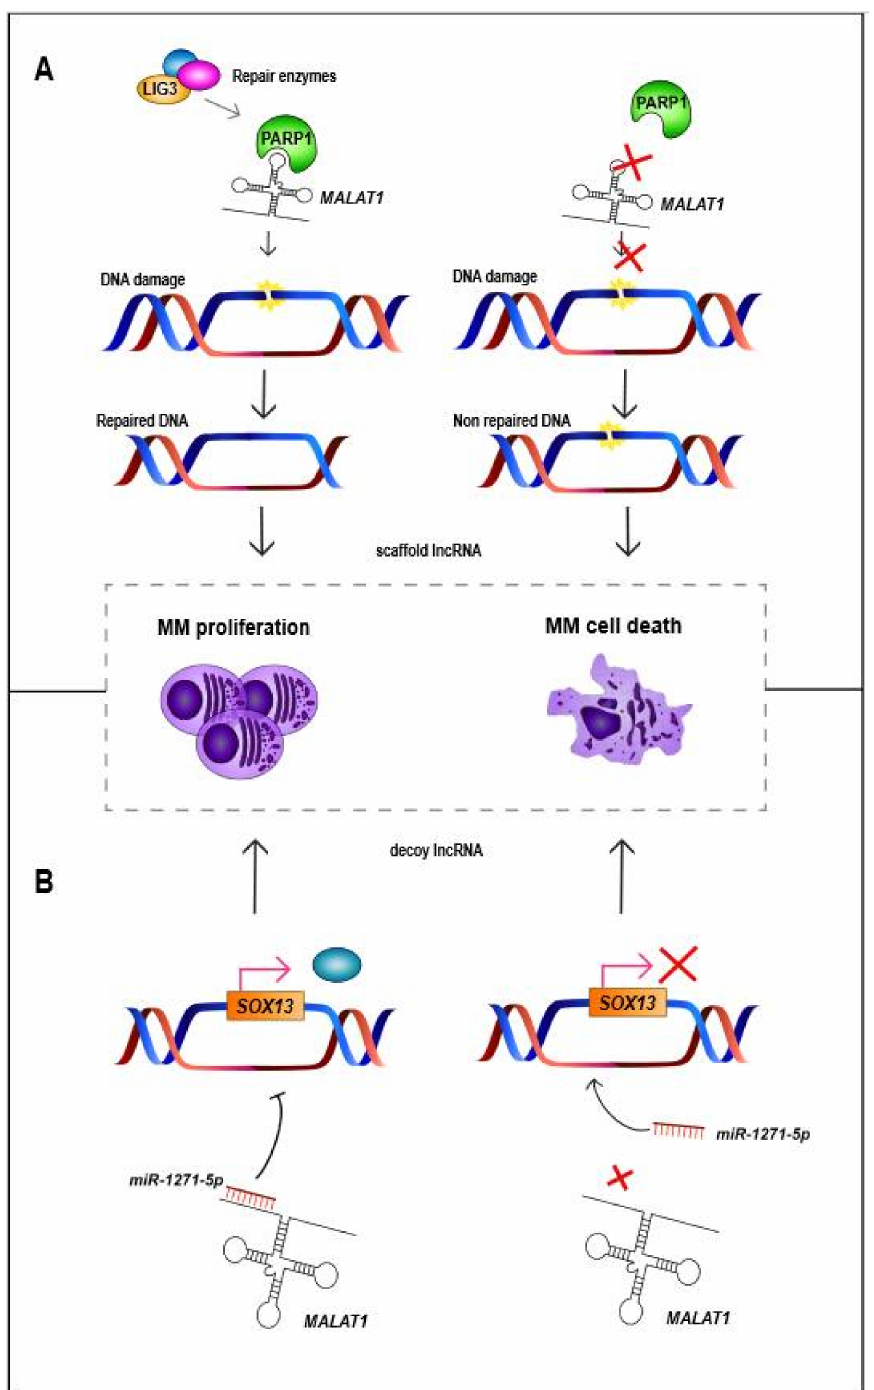
Figure 1. Mechanisms by which MALAT1 acts in MM cells. ( A ) MALAT1 acts as scaffold lncRNA, binding to PARP1 protein, which binds to a complex of DNA-repair enzymes consisting of LIG3 among others. Then, the protein– MALAT1 complex repairs the damaged DNA, triggering the pro- liferation of MM cells. However, when binding of MALAT1 and PARP1 does not occur, damaged DNA is not repaired, triggering MM cell death [70]. ( B ) MALAT1 can also act as a miRNA sponge (decoy), binding to different miRNAs such as miR-1271-5p , a tumor-suppressor miRNA that nega- tively regulates SOX13. Binding of MALAT1 and miR-1271-5p triggers overexpression of SOX13 and proliferation of MM cells, whereas knockdown of MALAT1 releases miR-1271-5p , which binds and prevents translation of SOX13. MM = multiple